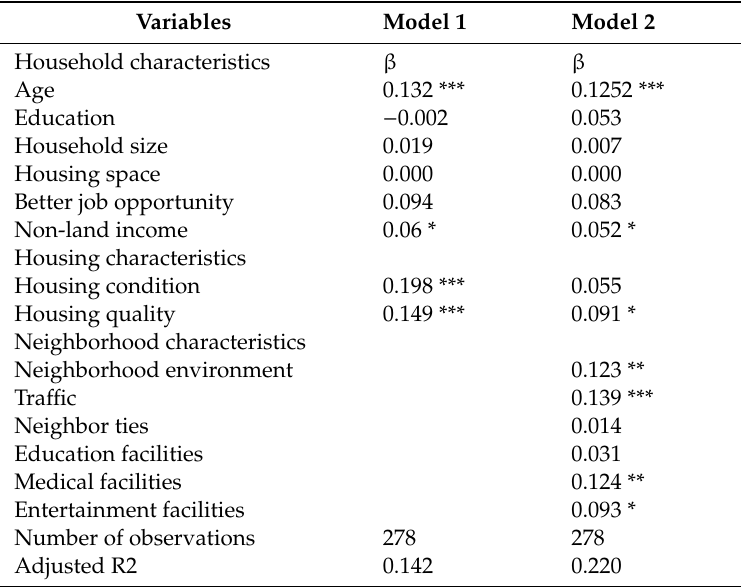
Table 5. Linear regression model results for the life